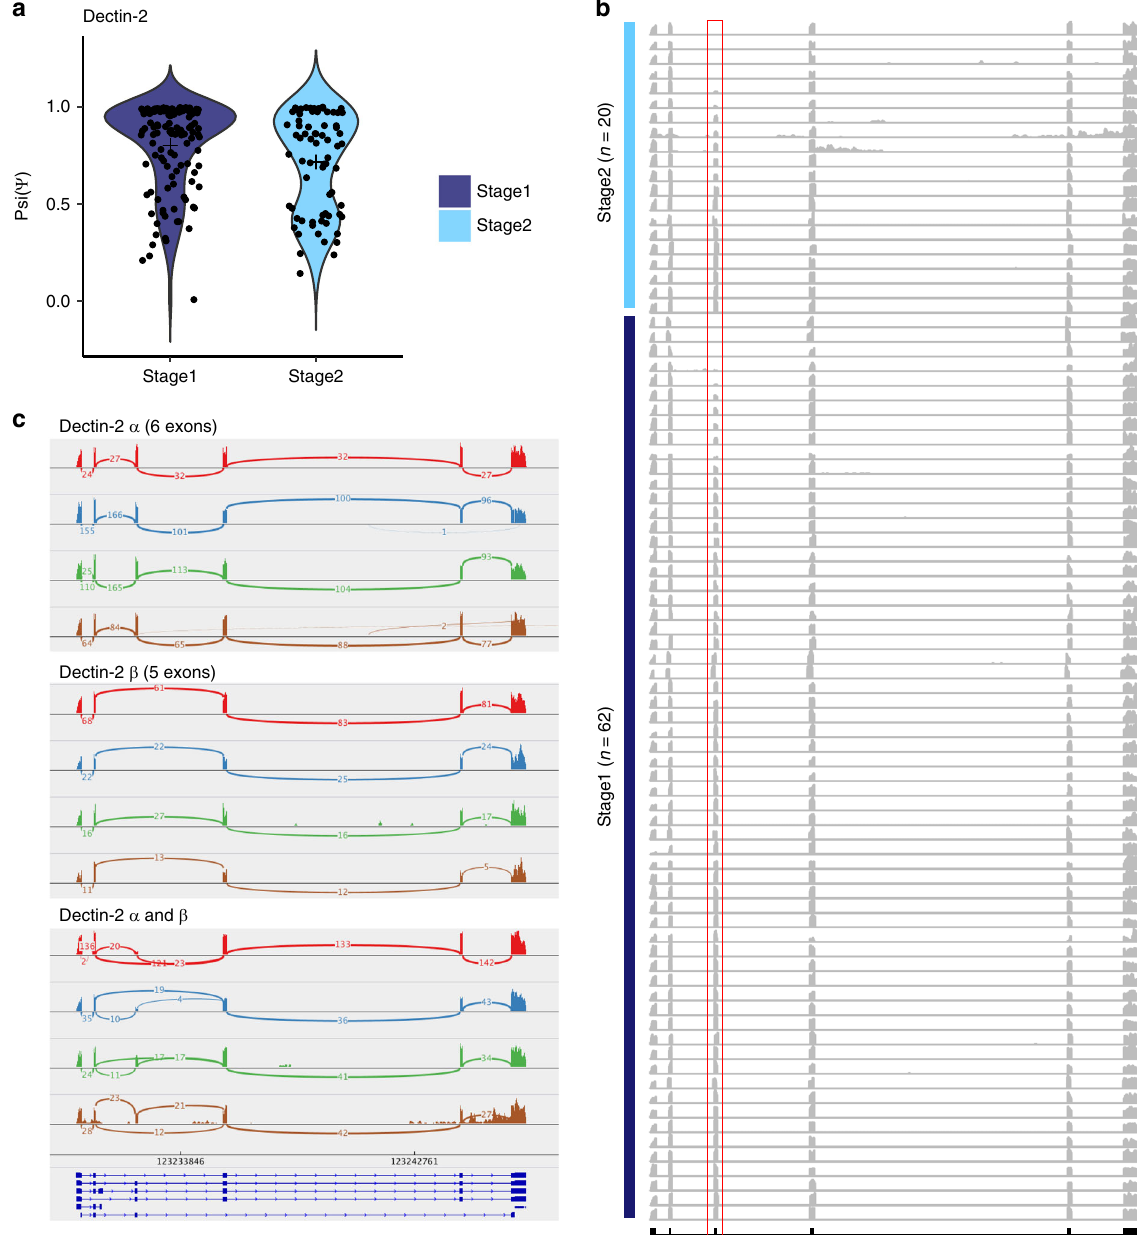
Fig. 6 Differential splicing and isoform usage in single infected macrophages. a Differential inclusion of exon 3 alternative splicing event in Clec4n (Dectin- 2) in single macrophages infected with C. albicans . Violin plots depict the distribution of the percent spliced-in (Psi/ Ψ ) scores for single macrophages in stage 1 and 2 of infection. b scRNA-seq densities for all exons of Dectin-2 across 82 single macrophages infected with C. albicans ; 62 in stage 1 and 20 in stage 2. Each row represents a single-cell. Red box indicates the spliced exon 3. c Sashimi plots showing differential splicing between single macrophages, including the read densities and number of junction reads. Four cells were selected showing three scenarios: top: Dectin-2 α , middle Dectin-2 β , and bottom cell with both